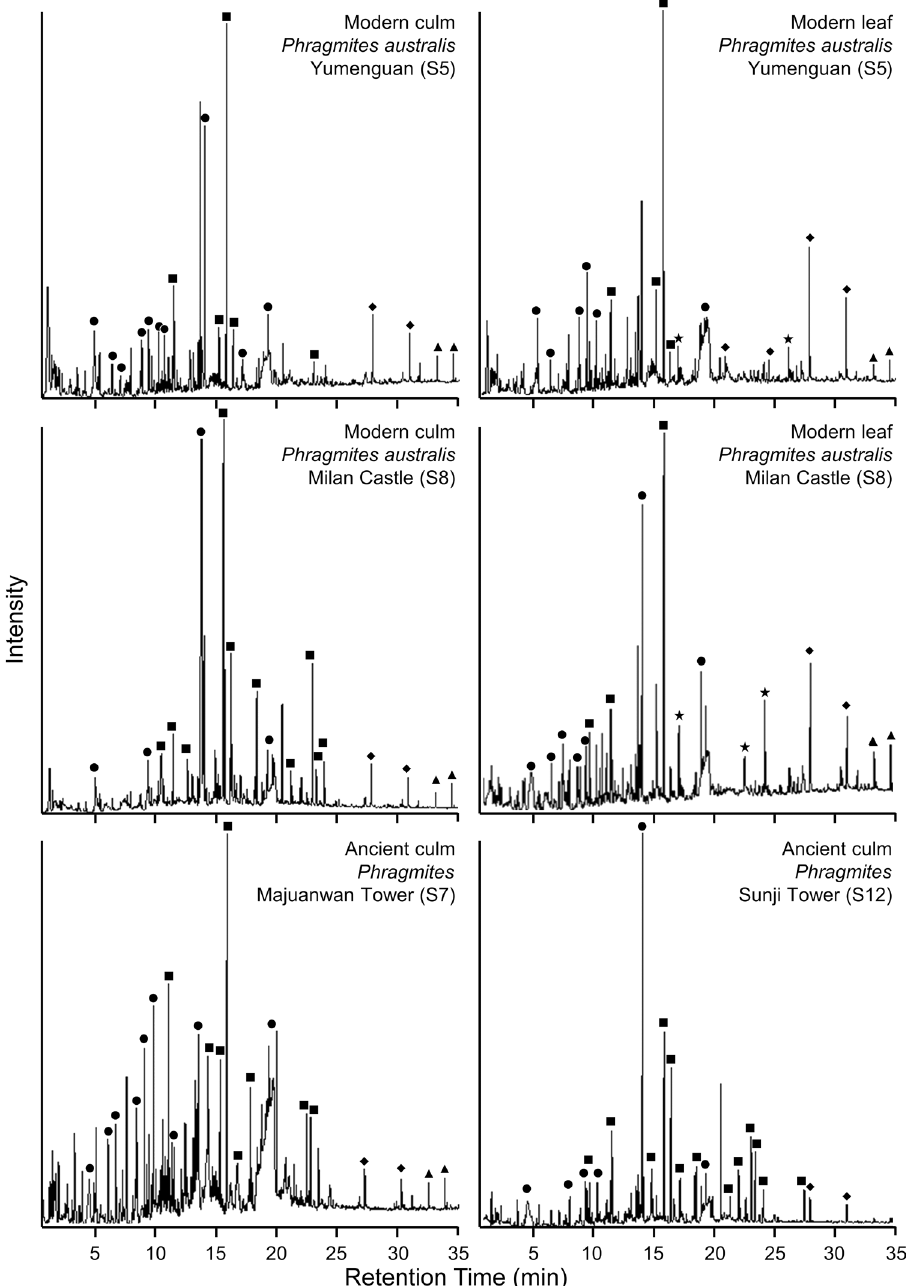
Figure 4. Partial ion chromatograms. The Py-GC-MS analysis of modern Phragmites australis culms and leaves and ancient Phragmites culms showing the distribution of (black circle) Polysaccharide, (black square) lignin, (black rhombus) fatty acid, (black star) amino acid, and (black triangle) n -alkanes. The “S,” as in S7, stands for “Site.” See Data S2 for compound